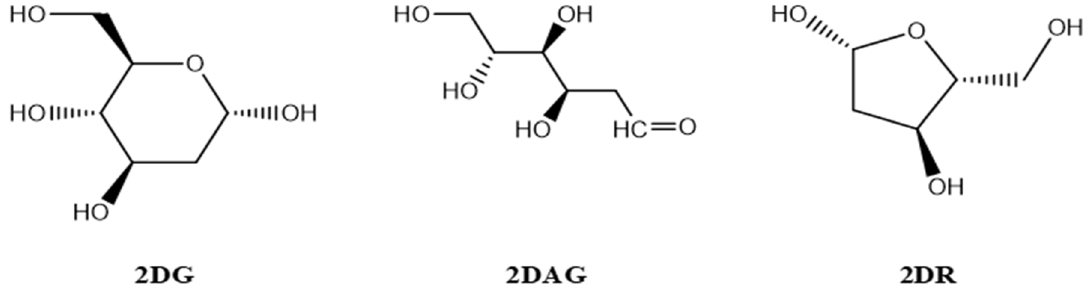
Figure 1. Structures of 2-deoxy-D-ribose ((2DR), 2-deoxy-glucose (2DAG) and 2-deoxy-D-glucose (2DG)).